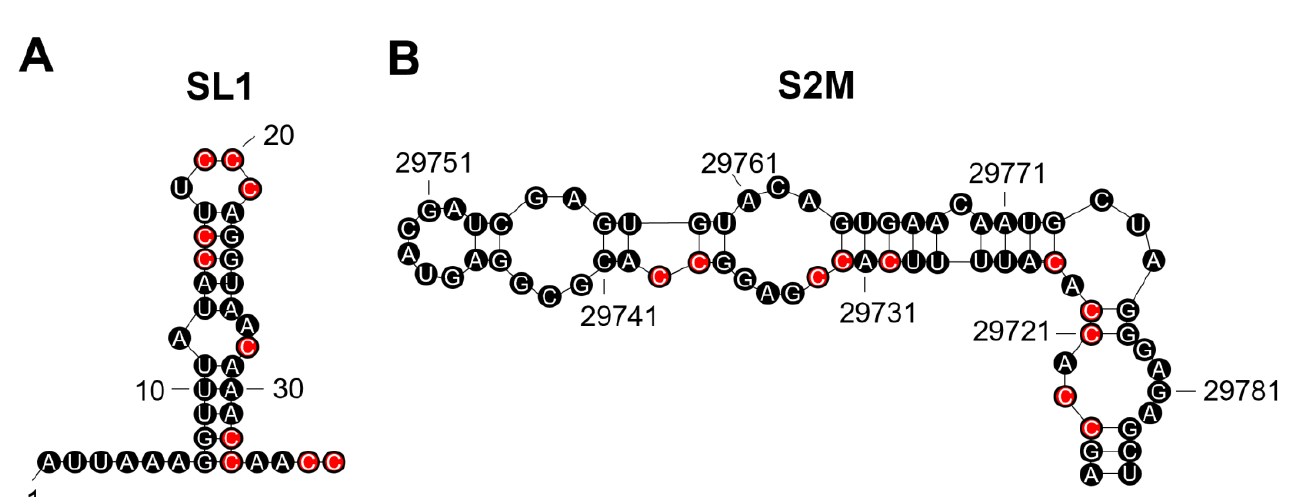
Figure 2. The stem-loop 1 (SL1) and stem-loop II-like motif (S2M) regions in the SARS-CoV-2 un- translated regions (UTRs) contain sequences on their positive strand which may allow G-quadruplex (G4) formation on the negative strand. Both the SL1 ( A ) and S2M ( B ) regions contain C-tracts on their positive sense RNA strand which may allow the formation of a G4 to occur on the negative sense strand. The cytosines which may be involved are highlighted in red. The reverse comple- mented sequence on the negative strand would be GGAAGGGUCCAUUGUUUGGUUGG (SL1) and GGUGGUGTAAAAGUGGCUCCGG (S2M). Both sequences have the potential to form G4s and G4-formation on the negative strand may prevent viral translation and replication.